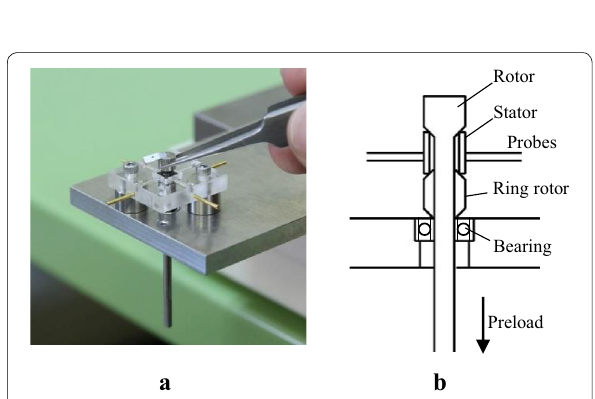
Fig. 9 Experimental setup for evaluating the motor performance measures, such as an angular velocity and